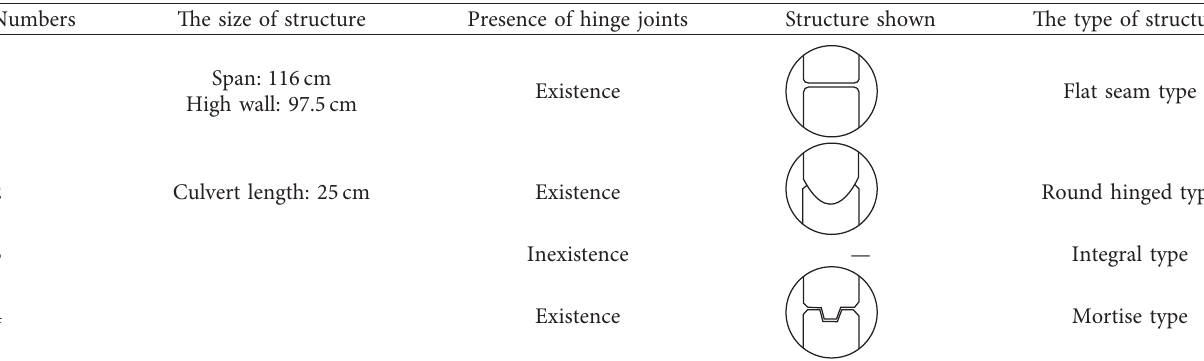
Table 1: List of scale